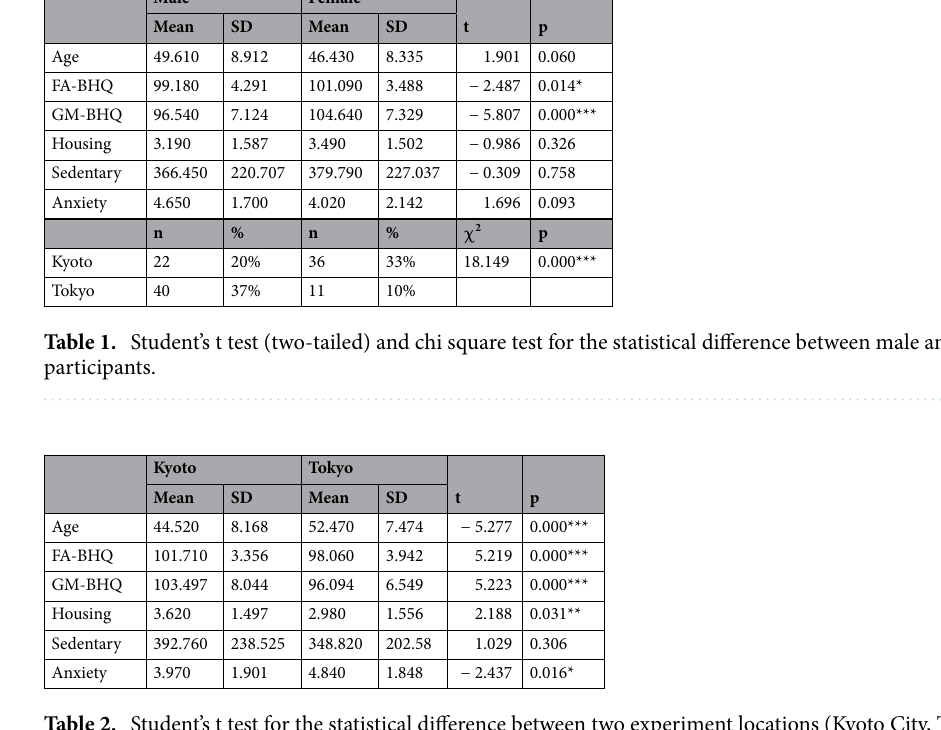
Table 2. Student’s t test for the statistical difference between two experiment locations (Kyoto City, Tokyo City).